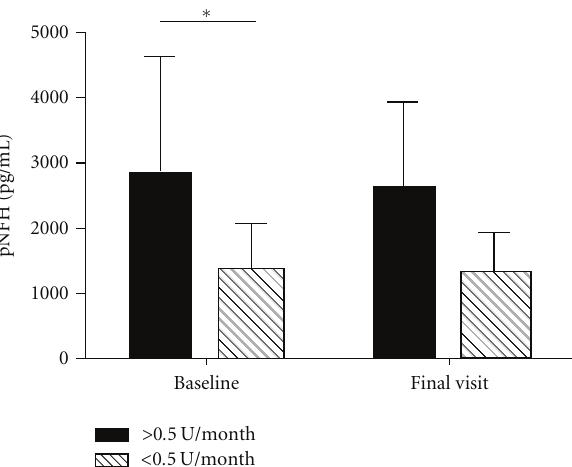
Figure 1: Levels of tau in CSF of patients in active arm ver- sus placebo arm at baseline and after six months of therapy. ( ∗ Significant di ff erence in levels of tau at baseline between the two groups, P = 0.02 by Mann-Whitney t -test). Error bars denote standard deviation.